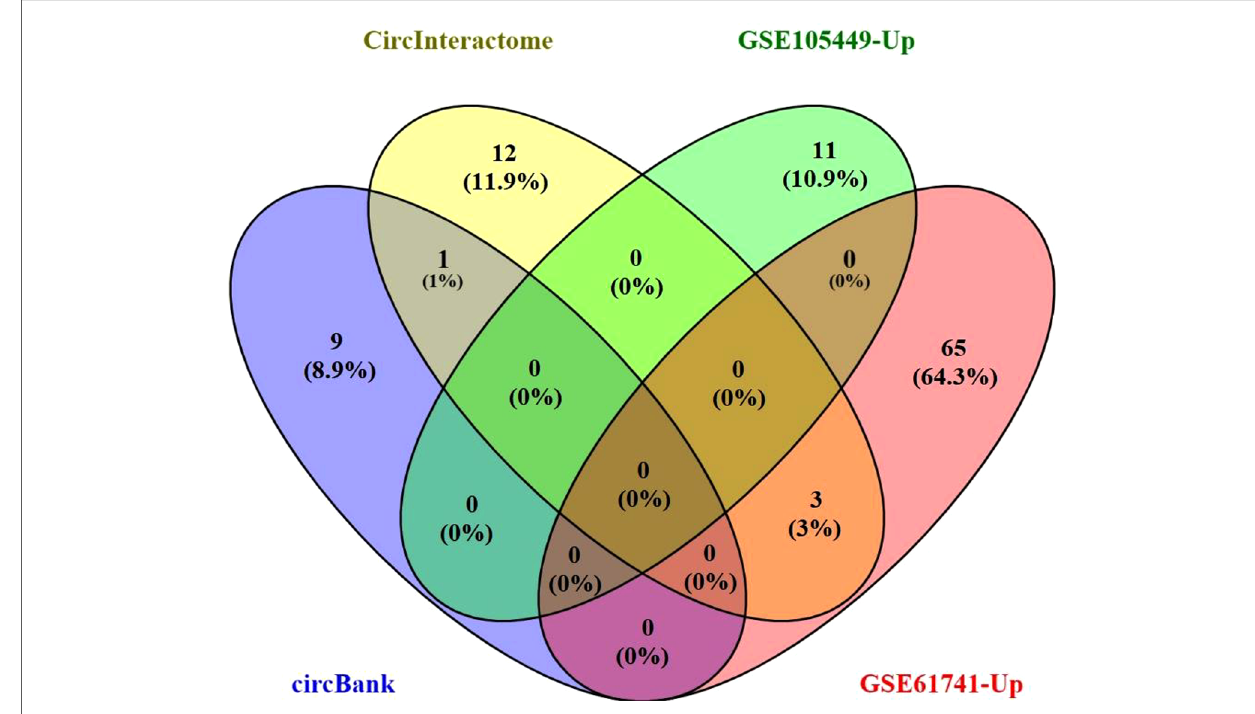
FIGURE 3 The Venn diagram for the overlap of numbers of the predicted